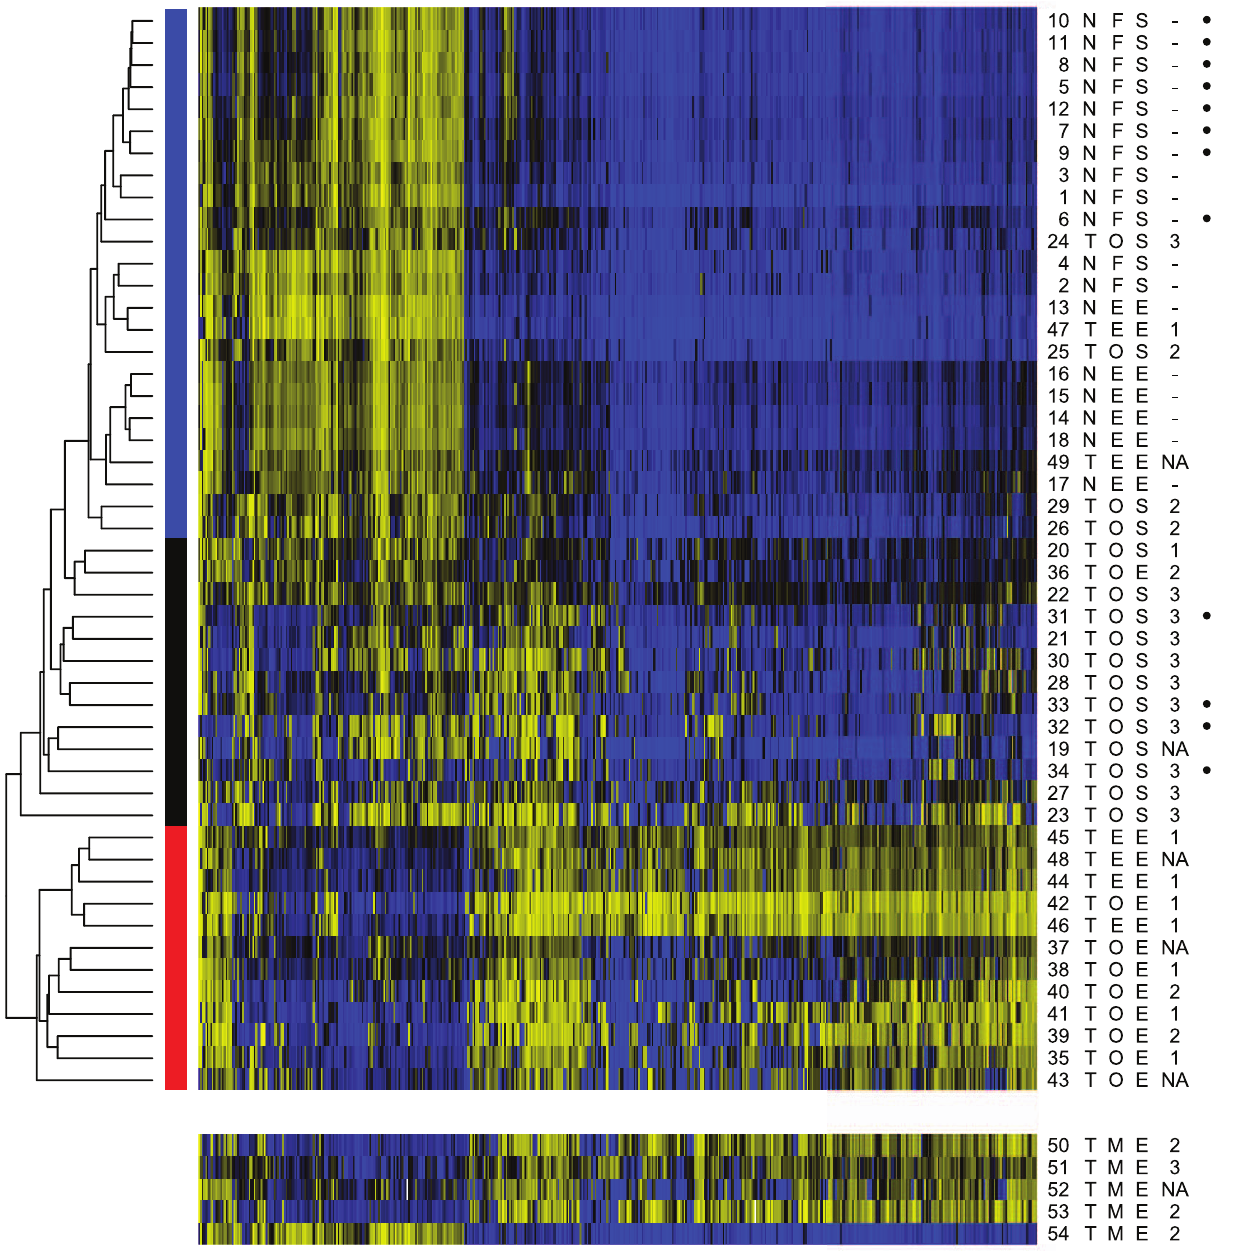
Figure 2. Methylation status at top 500 most variable probes. Heatmap of methylation levels; blue=0.0, black=0.5, yellow=1.0. At left, a representative sample of hierarchical clustering, and color blocks giving the consensus groups. Six columns on the right give sample characteristics: number; tumor (T) or normal (N); location in ovary (O), fallopian tube (F), or endometrium (E); histology of serous (S) or endometrioid (O); grade (1–3; where symbols used are ‘-’ for normals and ‘NA’ for information not available.) and at far right, dots for public TCGA data. Five samples at bottom are ovarian metastases from endometrial endometrioid tumors, excluded from the initial analysis and clustering.